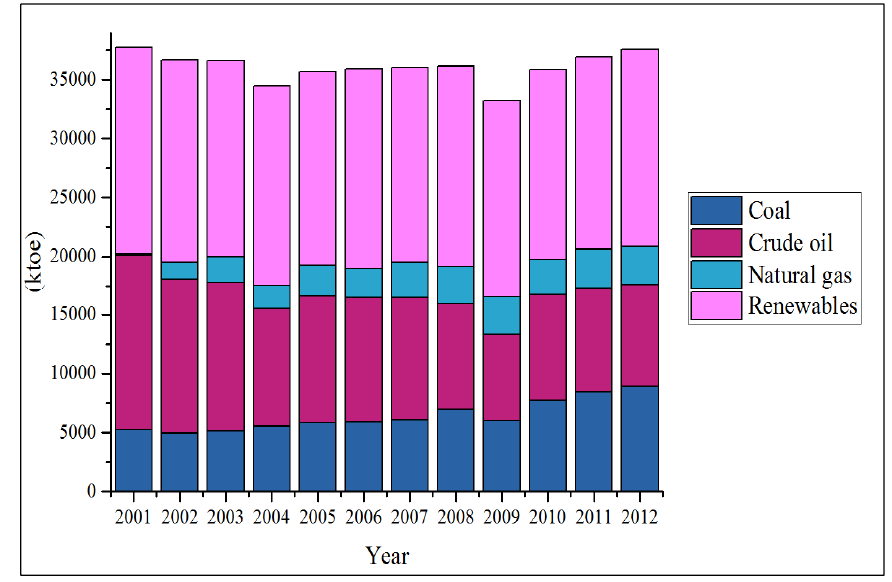
Figure 6. The Philippines: primary energy